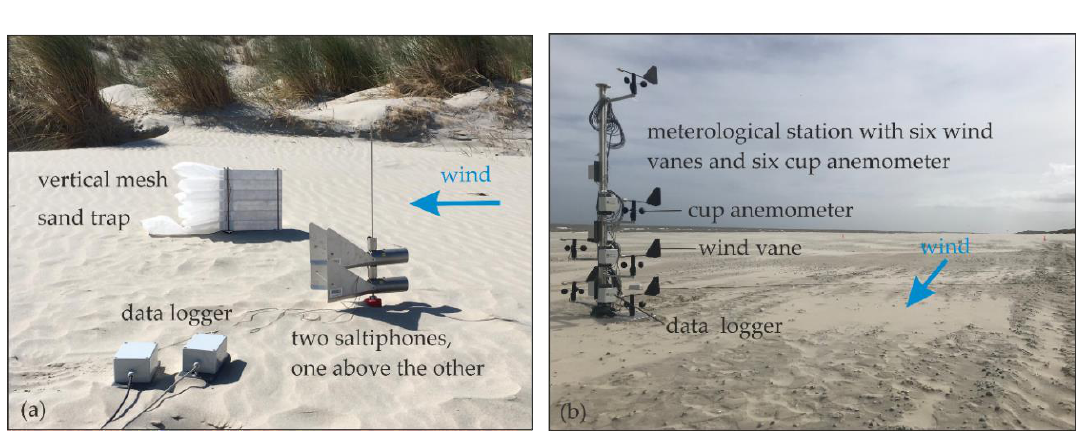
Figure 5. Measuring equipment at the beach of Langeoog, Germany, during the field campaign on 23 May 2020. ( a ) Modified vertical mesh sand trap as well as an array of two saltiphones with respective data loggers, ( b ) meteorological measuring station with six cup anemometers, six wind vanes, and six data loggers. Blue arrows indicate the respective wind direction during measurements.